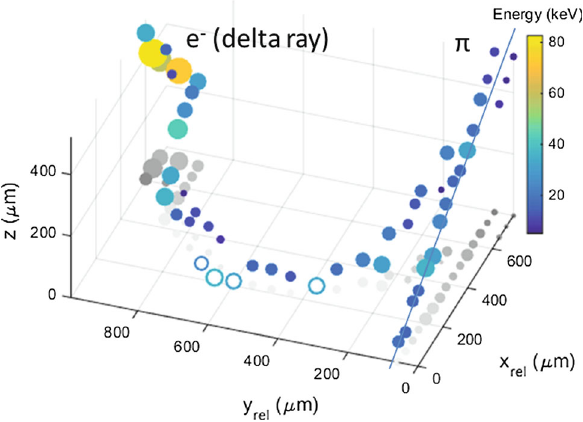
Fig. 11 Same as Fig. 9, but for a track from the measurement with 175V bias